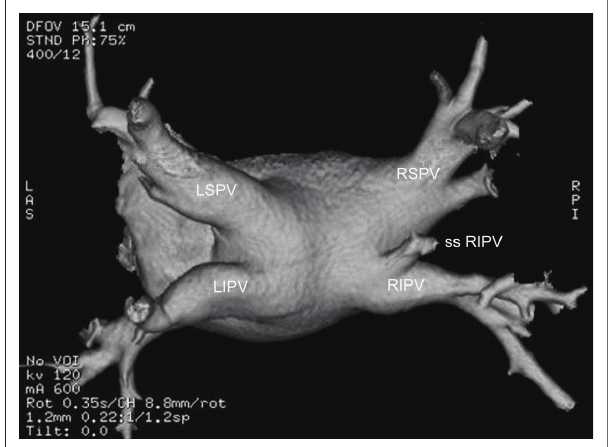
RSPV, right superior pulmonary vein; ss RIPV, superior segment right inferior pulmonary vein; RIPV, right inferior pulmonary vein; LSPV, left superior pulmonary vein; LIPV, left inferior pulmonary vein. FIGURE 4: Supernumerary vein in another patient with atrial fibrillation. A vein draining the superior segment of the right lower lobe pulmonary vein draining directly into the left atrium, 3D view of the left atrium shows the right superior pulmonary vein (RSPV), the superior segment of the right lower lobe pulmonary vein (ss RIPV), the right inferior pulmonary vein proper (RIPV), the left superior pulmonary vein (LSPV) and the left inferior pulmonary vein (LIPV).